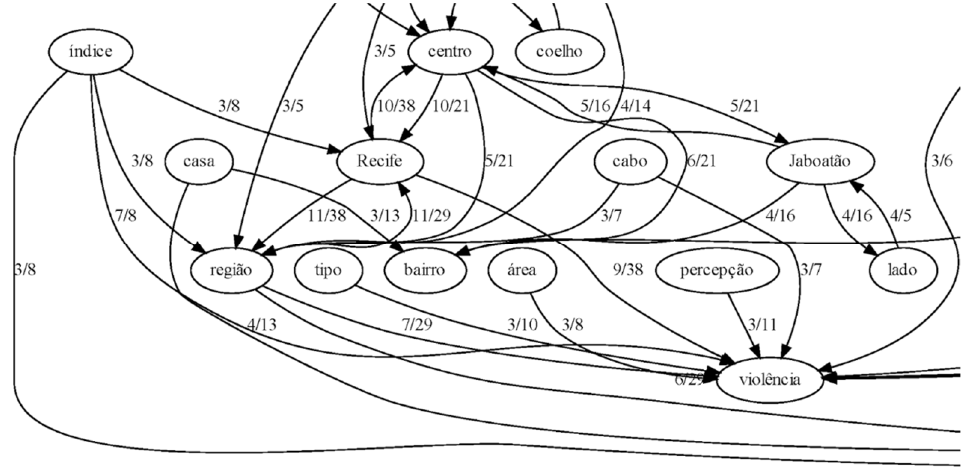
Figure 4. Section of the association rules derived from interviews with civilians after being shown the VGI-based maps. The prototypical concepts behind the binding to places become visible: região, bairro, área, centro .